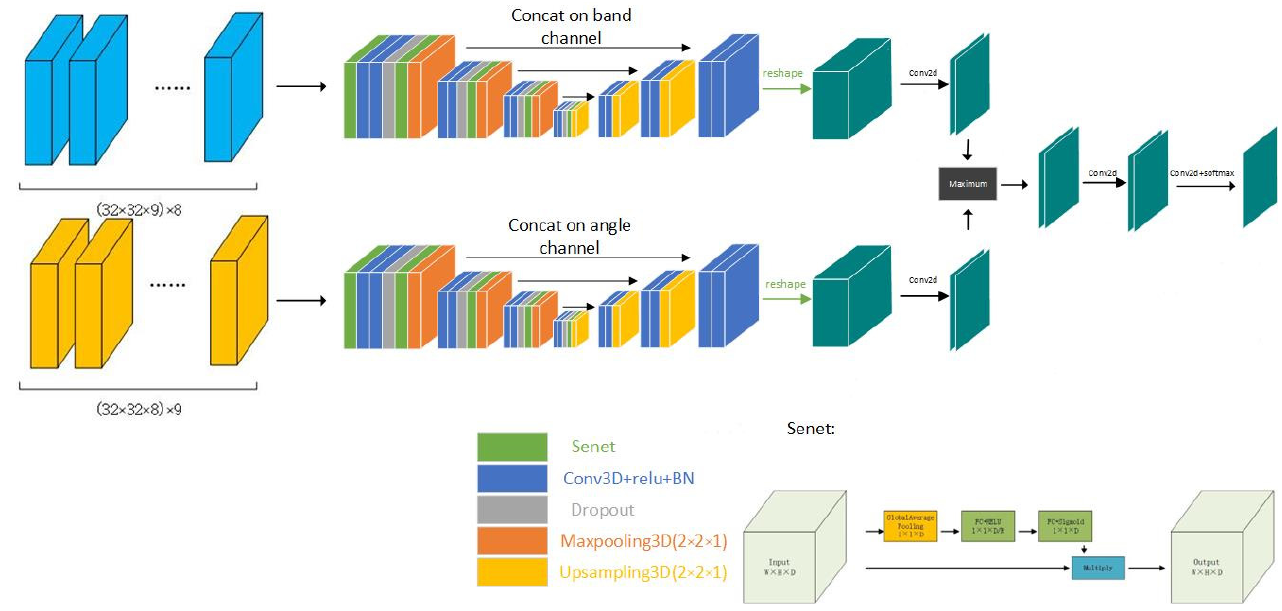
Figure 7. Network flow